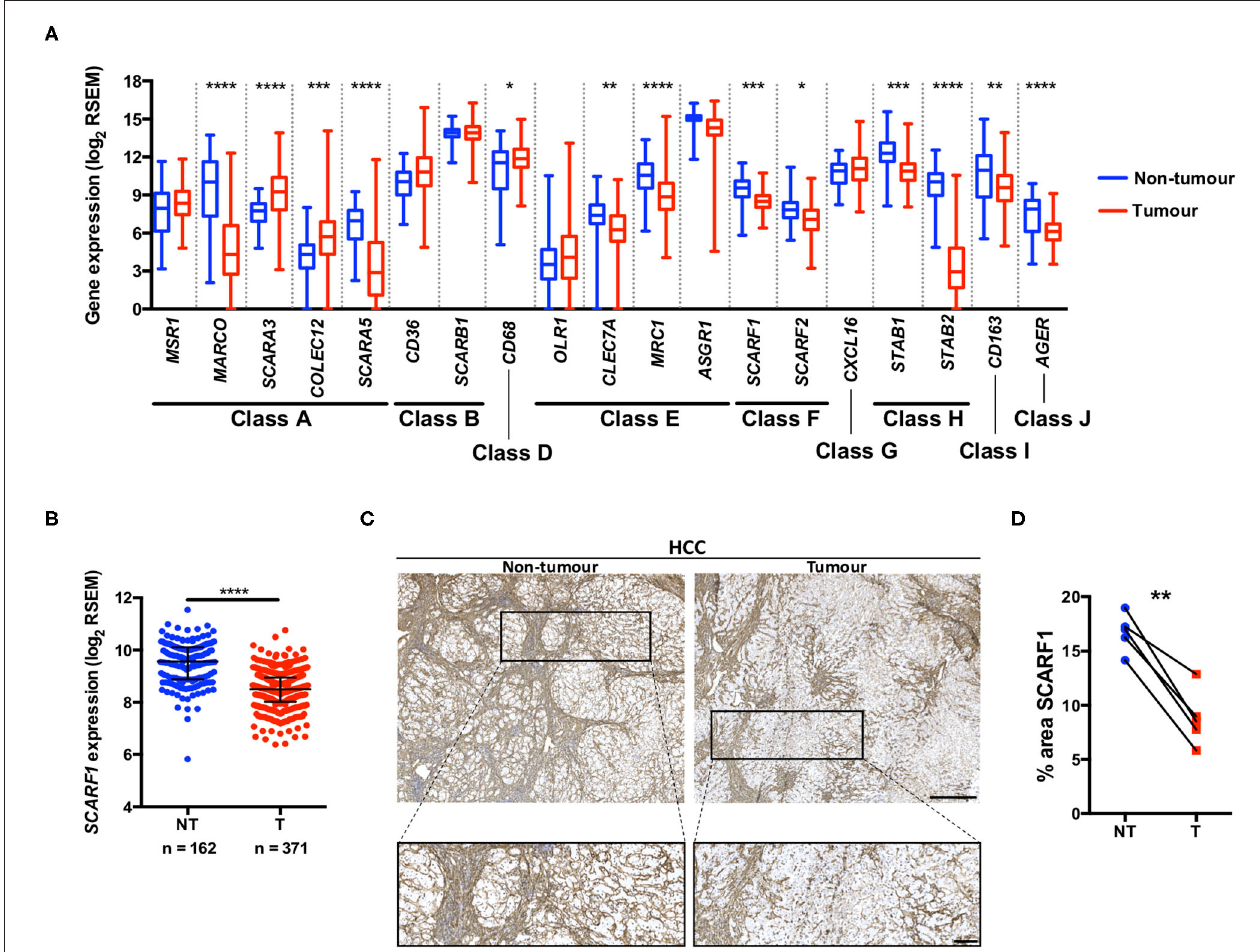
FIGURE 1 | SCARF1 gene and protein expression is downregulated in HCC tumors. (A) Regulation of scavenger receptor gene expression in HCC tumors (blue; n = 371), compared to non-tumoral tissues (red; n = 162). *, **, *** and **** are representative of statistical significance as measured by the Kruskal–Wallis test, where p ≤ 0.05, p ≤ 0.01, p ≤ 0.005, and p ≤ 0.001, respectively. RSEM = RNA-Seq by Expectation Maximization. (B) Comparison of SCARF1 gene expression in non-tumoral (NT) tissues with HCC tumor tissues (T). ****Indicates statistical significance as measured by Mann–Whitney U -test, where p ≤ 0.001 (C) . Representative images of SCARF1 immunohistochemical staining (brown) in HCC tumor (Right panels) and matched distal, non-tumorous (Left panels) tissues from the same patient. Scale bar = 400 µ m; zoomed image scale bar = 100 µ m. (D) Surface area quantification of immunohistochemical staining in matched HCC tumor (T) and non-tumorous (NT) tissues was performed by via threshold analysis using ImageJ software. **Indicates statistical significance as measured by a paired T -test, where p ≤ 0.01. n = 5, with the average of 5 random high-power fields of view taken per section. Data in (A,B) was generated from the TGCA dataset using the University of California Santa Cruz (UCSC) Xena tool